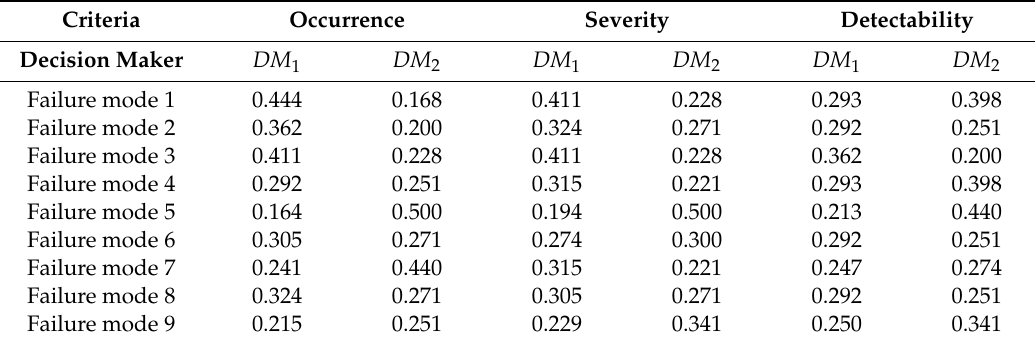
Table 7. Evaluation of the failure modes in each criterion by the